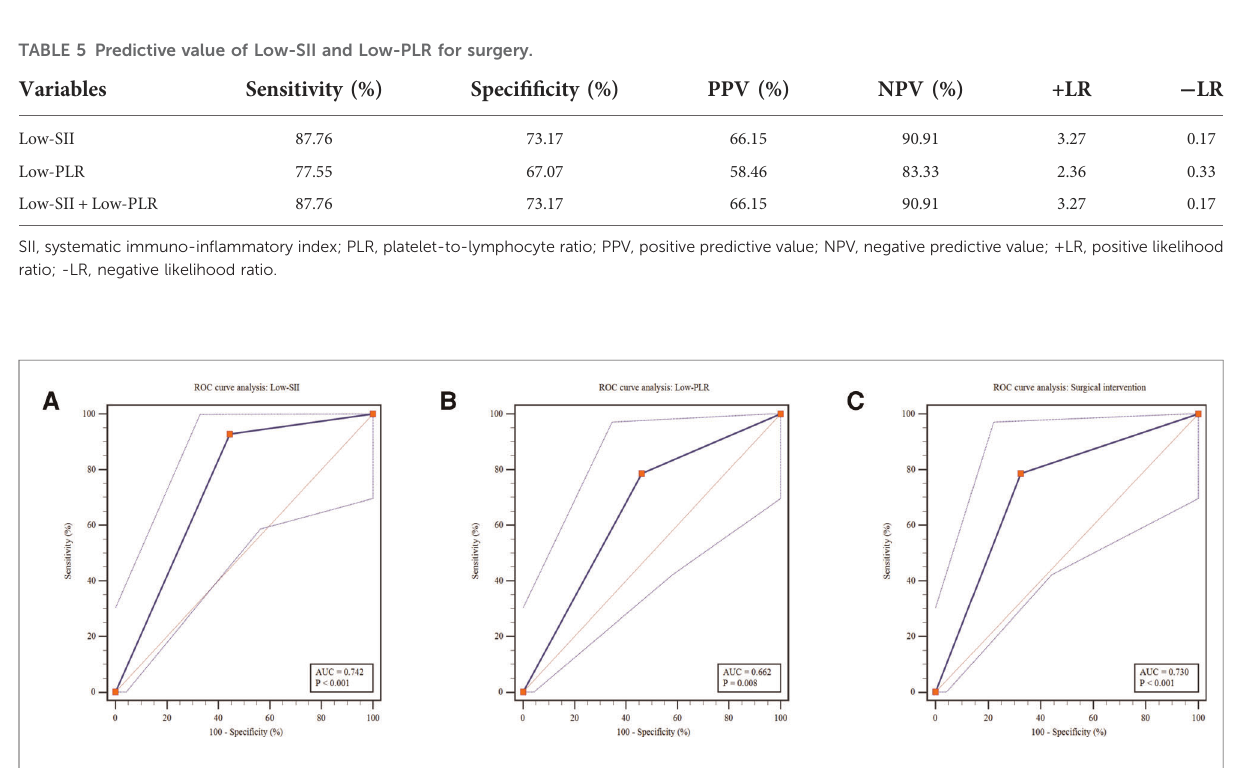
FIGURE 5 Predictive analysis of outcome for Low-SII, Low-PLR and surgical intervention. ROC, receiver operating characteristics; AUC, area under the Curve; SII, systemic immune-in fl ammation index; PLR, platelet-to-lymphocyte